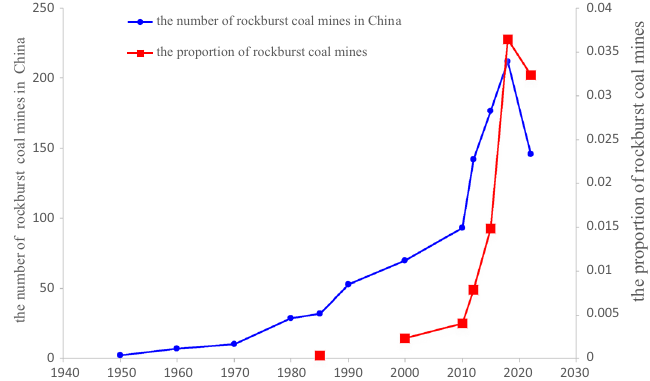
Figure 1. The number of rockburst coal mines in China.